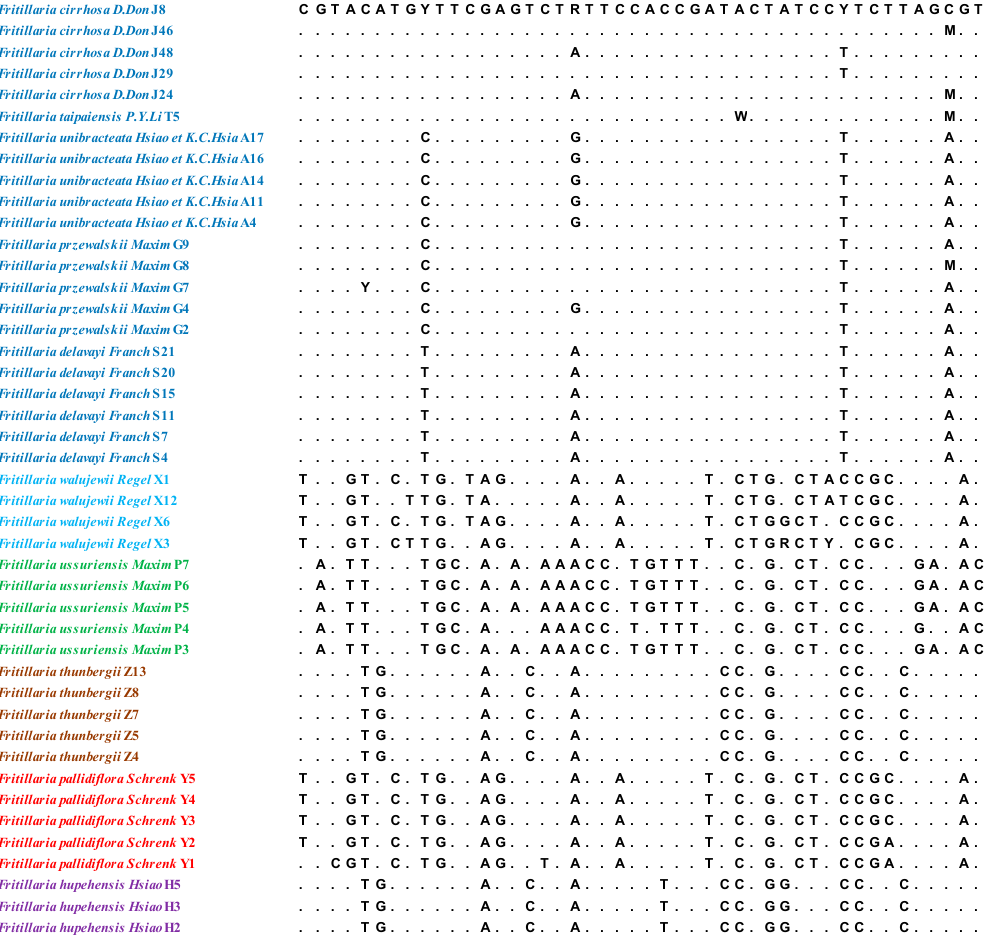
Figure 1. The intraspecific variable sites in the internal transcribed spacer region (ITS) sequences of Fritillariae Bulbus.